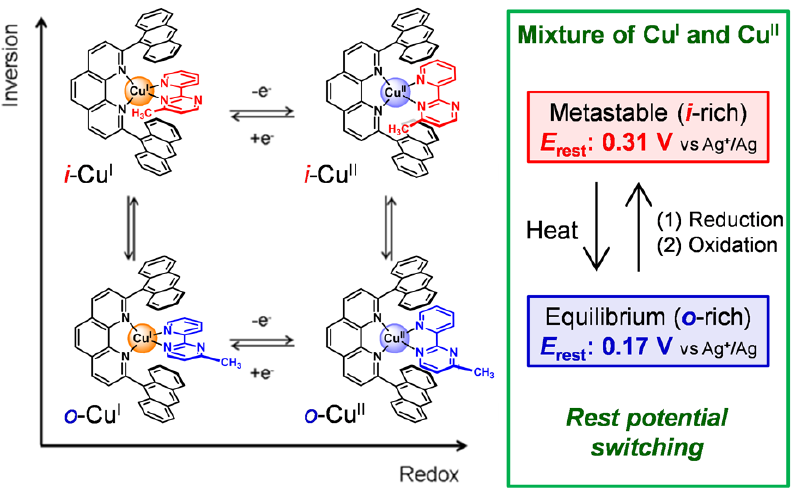
o -Cu I , i -Cu II , and o -Cu II in a 4-methyl-2-(2′-pyridyl)pyrimidine copper complex;